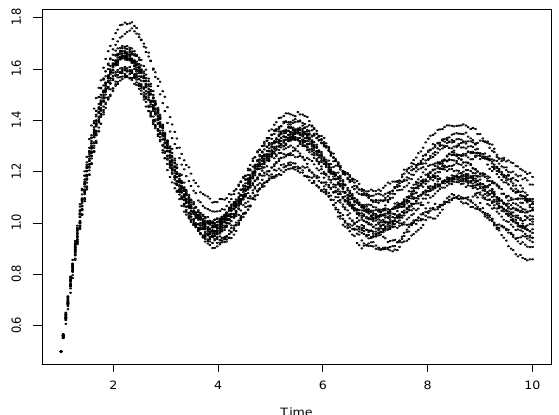
Figure 6. Simulated sample paths for the oscillabolastic lognormal-type diffusion process. Parameters: α (cid:48) = − 1, β = 2, γ (cid:48) = 1, θ = 0.5 and σ 2 = 10 − 3 .